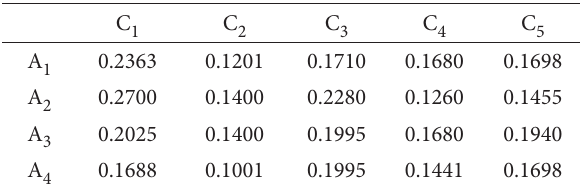
Table 6. WASPAS weighted and normalized decision making matrix for summarizing